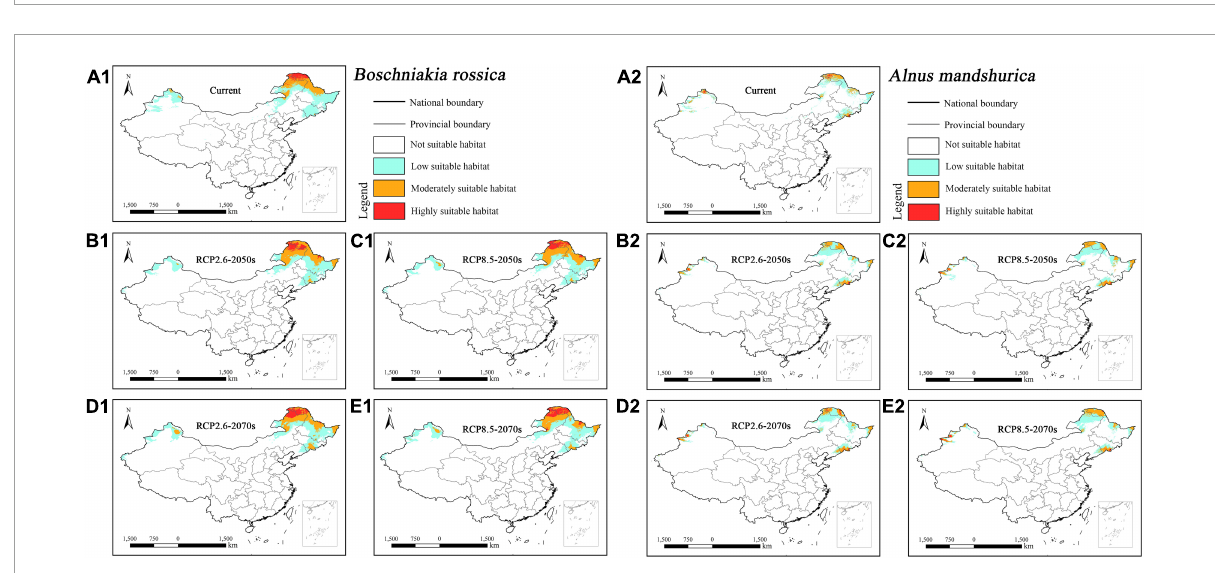
FIGURE4 Predicted suitable habitat distributions of Boschniakia rossica (A1–E1) and its host Alnus mandshurica (A2–E2) under different climate scenarios in